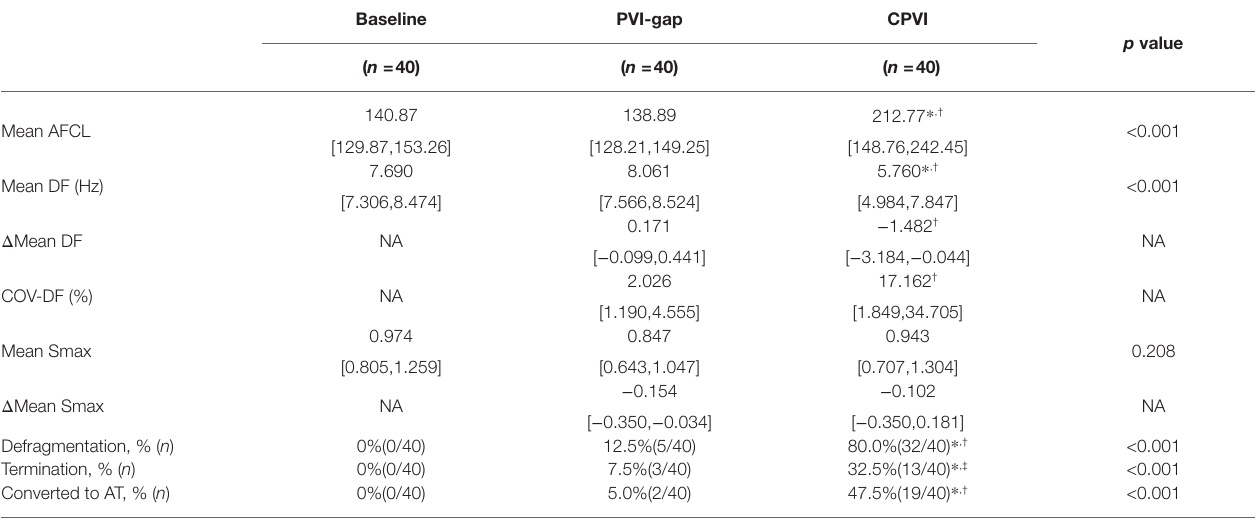
TABLE 1 | Wave-dynamic changes and defragmentation after virtual PV interventions. Baseline